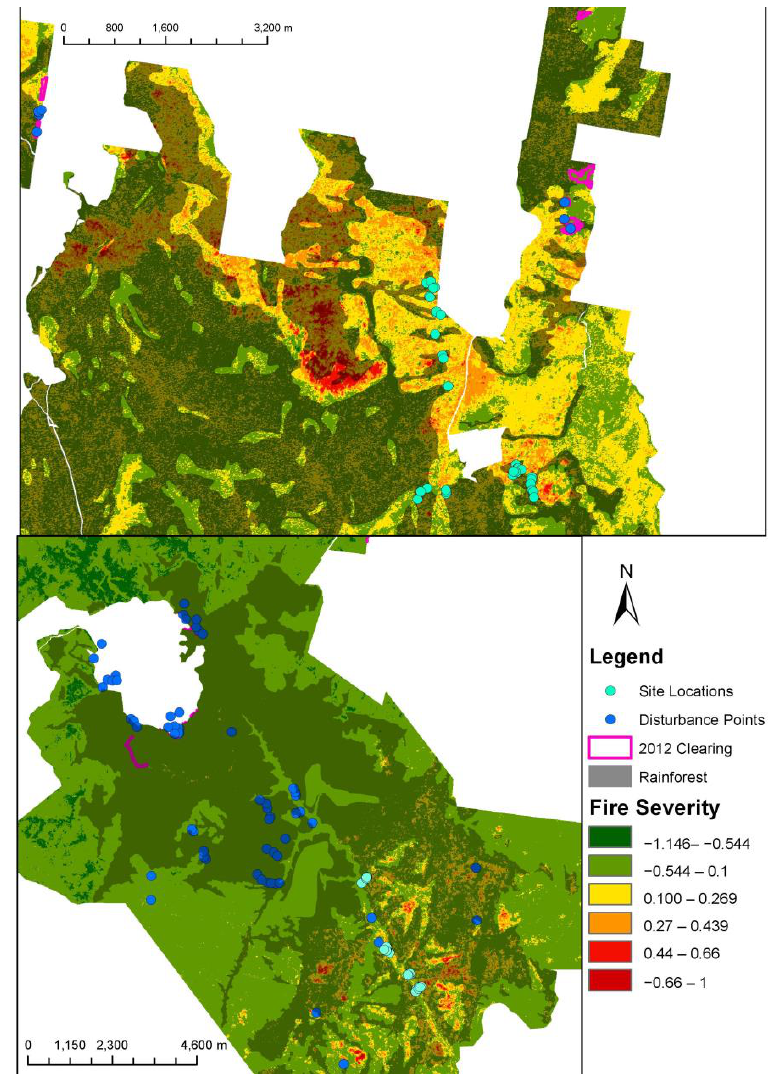
Figure 5. Locations; Lamington NP (top). Bulburin NP (below) with dNBR raster, site locations, disturbance points, rainforest, and clearings 2012 data.